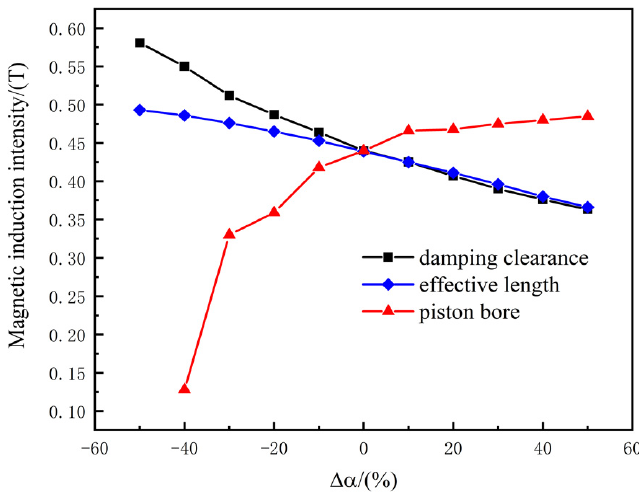
Figure 21. Effect of structural parameters on magnetic flux density at damping channel.